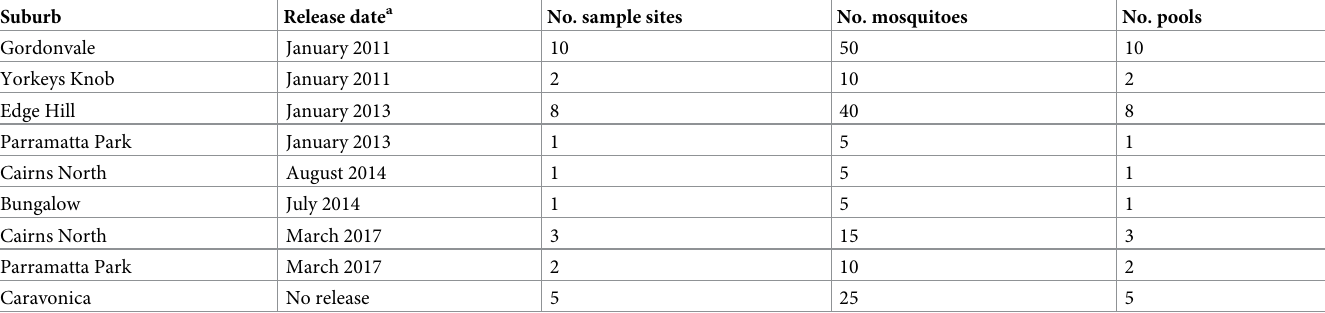
Table 1. Aedes aegypti collected in April 2019 from Cairns, Queensland, Australia, for mosquito transcriptome